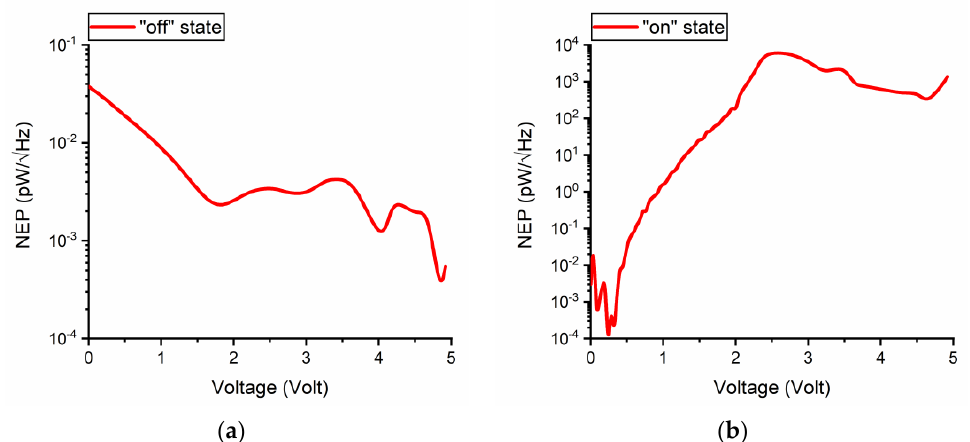
Figure 9. Dependence of the differential resistance R D on the applied DC voltage for the ( a ) OFF- and ( b ) ON-state of the DC switch.